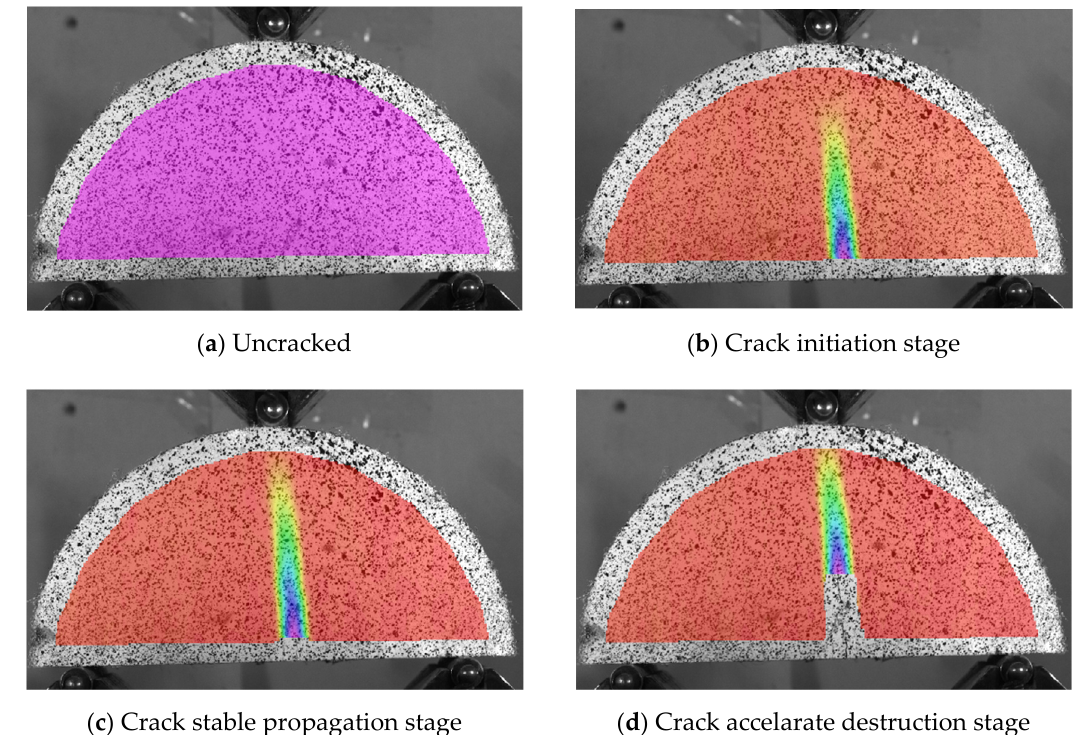
Figure 7. Surface transverse strain field under stress ratio 0.5.